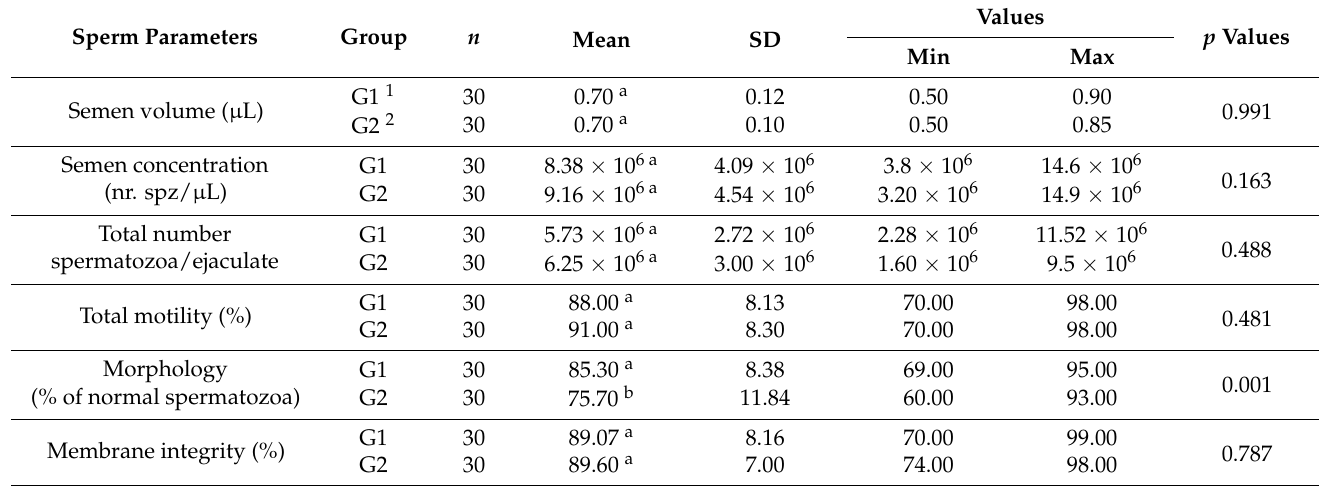
Table 1. Evaluation of sperm parameters in A. mellifera